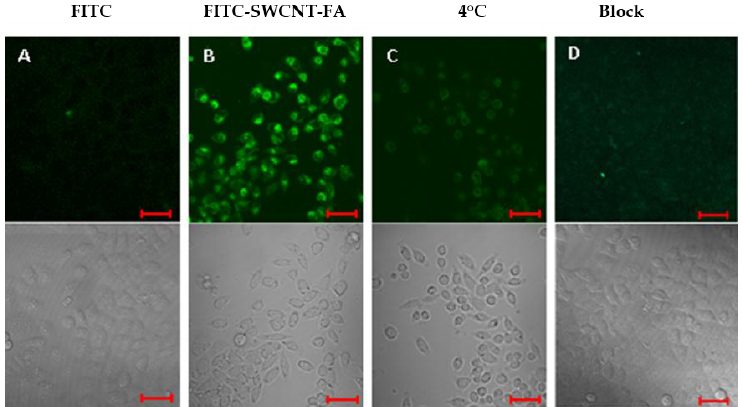
Figure 4. Optical microscopy images of HeLa cells incubated with FITC ( A ); FITC-SWCNT-FA at 37 °C ( B ) or 4 °C ( C ); and FITC-SWCNT-FA in the presence of free FA (denoted as Block, D ). Confocal fluorescence images ( top ) and transmittance images ( bottom ). Scale bar, 50 μm.